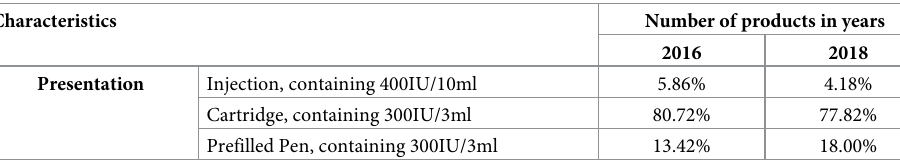
Table 3. Dosage form of insulin products found in the